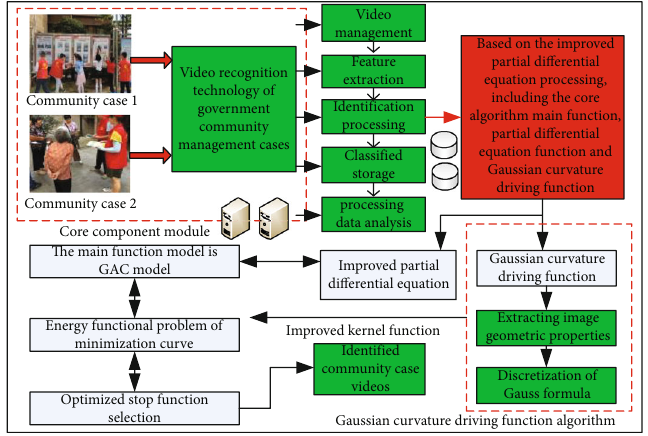
Figure 1: Principle block diagram of the improved partial di ff erential equation video recognition algorithm.